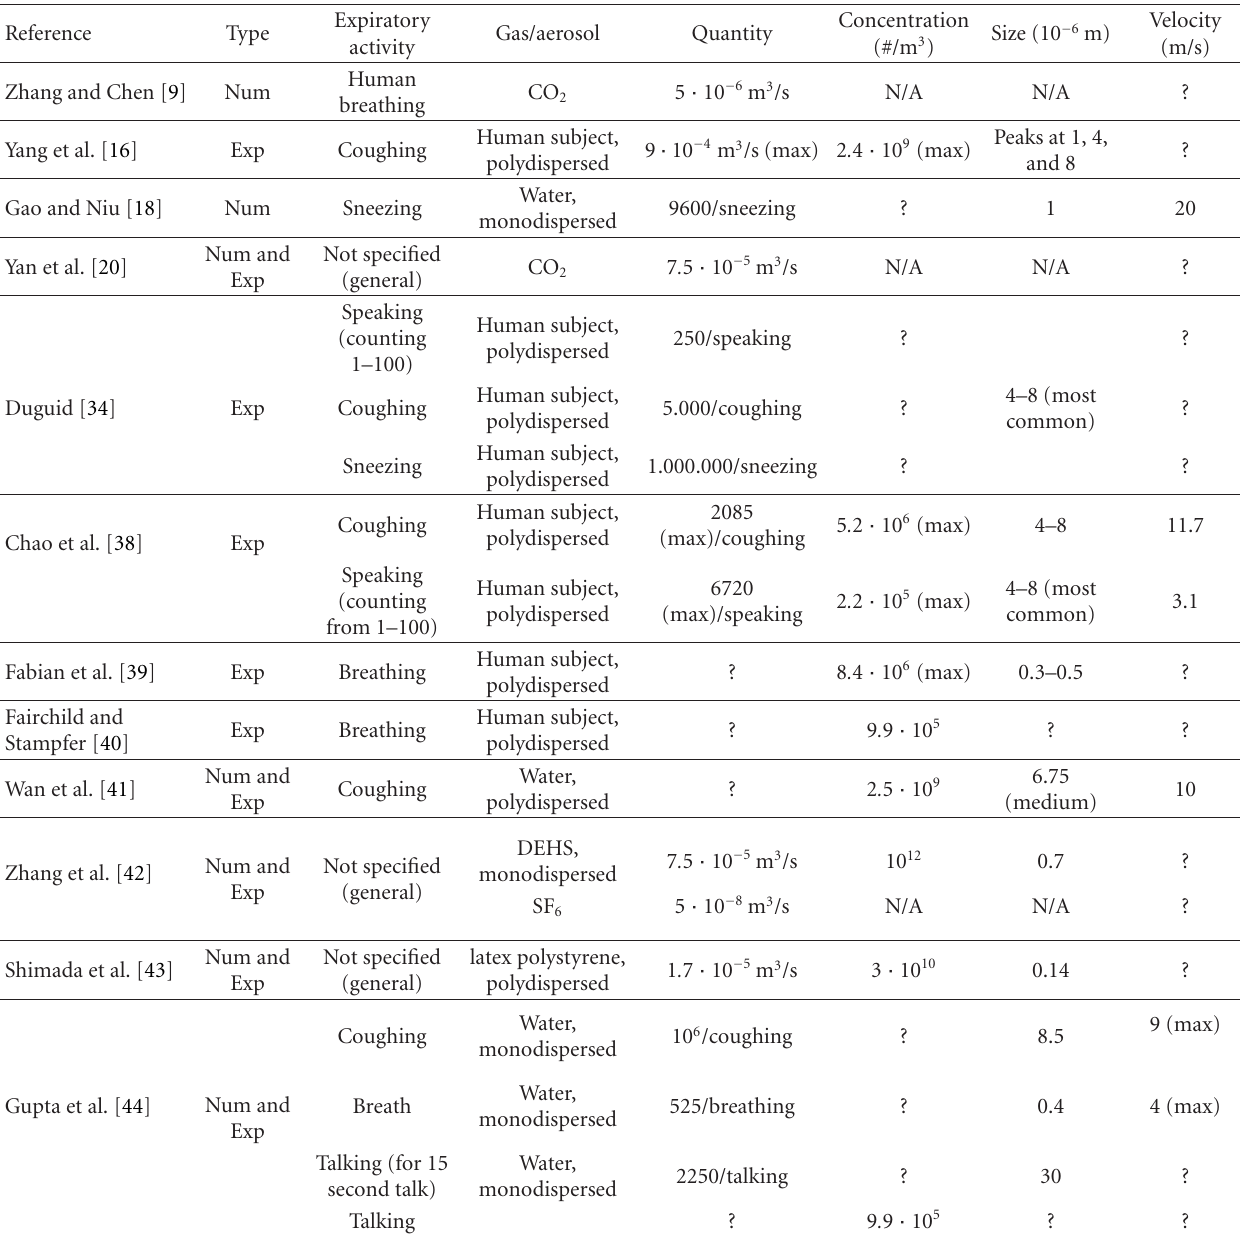
Table 2: Expiratory droplet